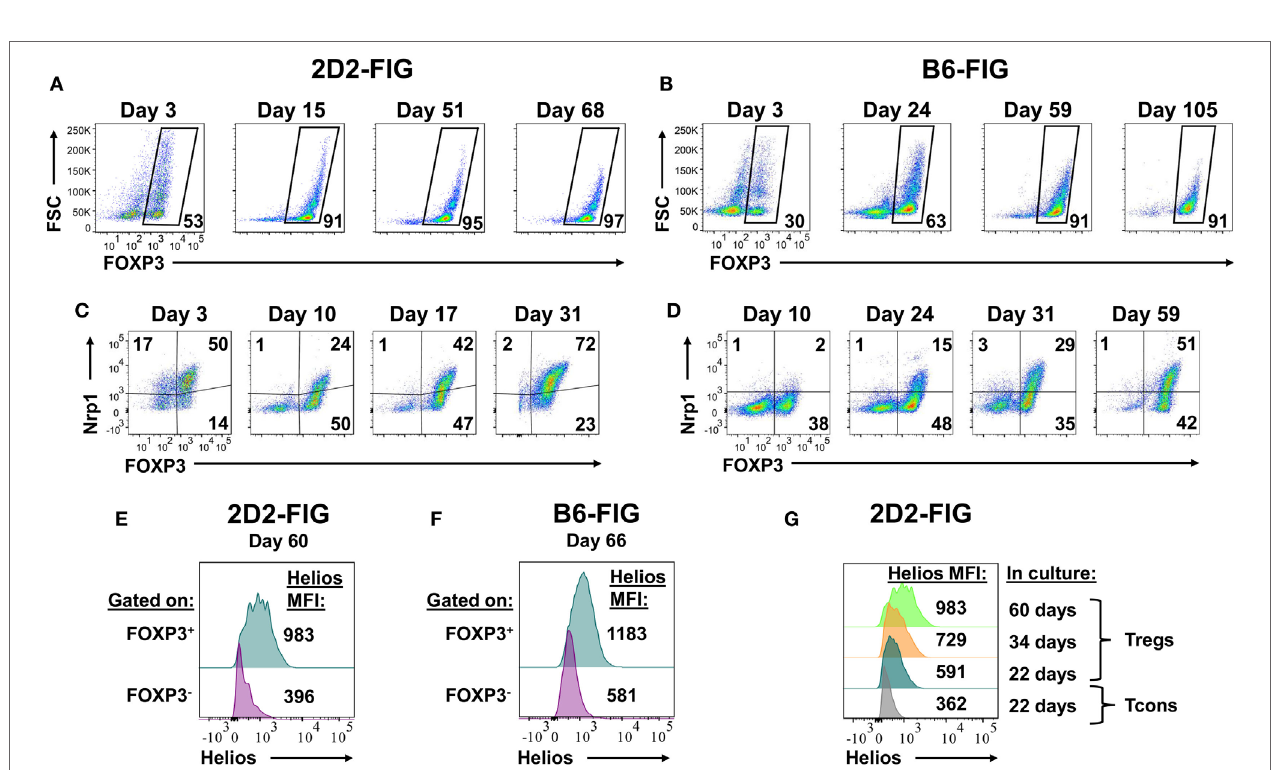
FigUre 7 | The anti-CD25 monoclonal antibody PC61 enabled long-term, stable propagation of FOXP3 + regulatory T cells (Tregs). 2D2-FIG splenocytes (SPL) or FIG SPL were activated with 1 µM MOG35-55 or 2.5 µg/ml Con-A, respectively, at a density of 2 × 10 6 SPL/ml in the presence of 10 nM TGF- β . After 3 days of activation, cells were passaged at a density of 10 6 cells/ml in media containing rat IL-2 and 10 µg/ml PC61. Cells were passaged every 3–4 days in the same conditions for the indicated durations. In 2D2-FIG cultures, V β 11 + cells were analyzed on the indicated days for FOXP3 expression (a) , Neuropilin-1 expression (c) , and Helios expression (e,g) . Panels (a,c) represent analyses of lines established from separate mice. (B,D,F) In C57BL/6 (B6)-FIG cultures, CD4 + T cells were purified to remove CD8 + T cells. FIG lines were analyzed for FOXP3 expression (B) , Neuropilin expression (D) , and Helios expression (F) . For panels (e,F) , Helios expression was measured in the FOXP3 + and the FOXP3 − populations from the same line. These experiments are representative of three independent